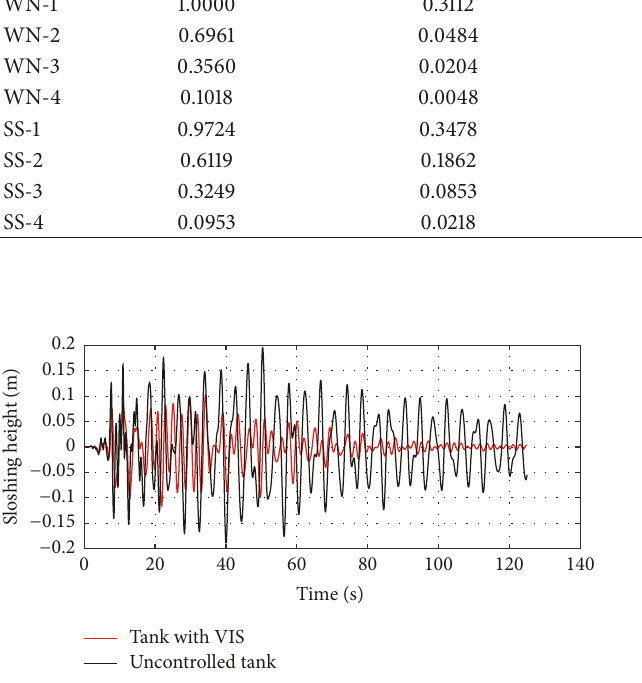
Figure11:Dynamicresponsesofthesloshingheightofthetankwith the VIS under the excitation of the Chi-Chi earthquake.